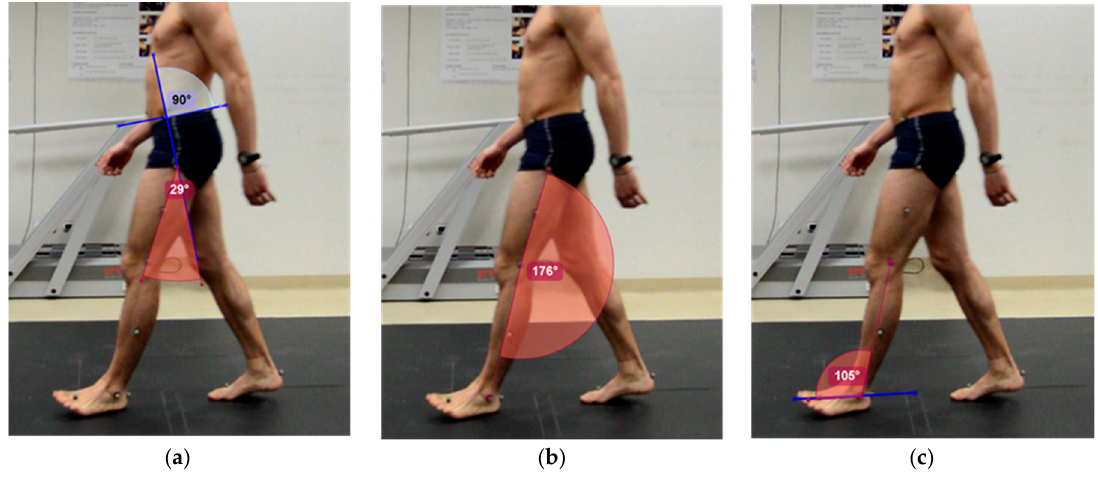
Figure 2. Joint angles calculation using Kinovea ® in ( a ) hip, ( b ) knee and ( c ) ankle.